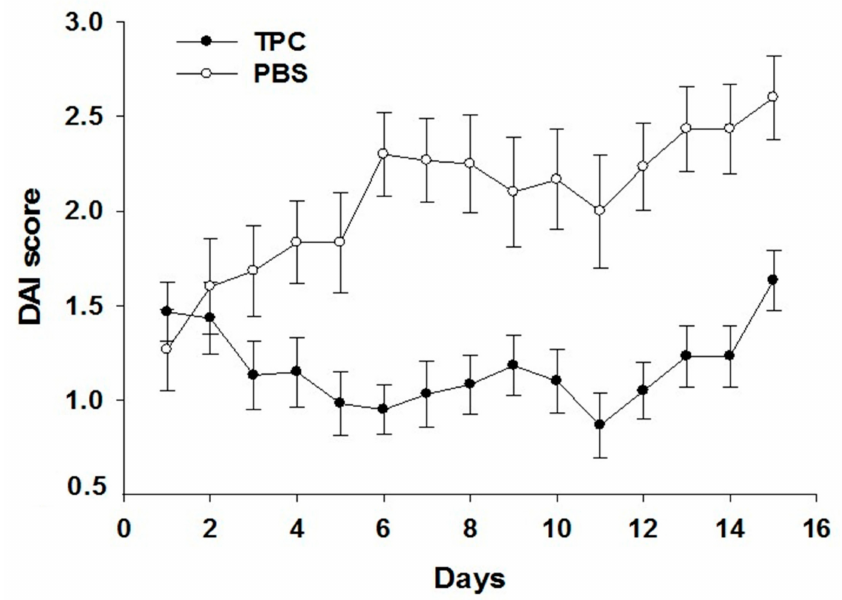
Figure 2. The e ff ect of TPC on disease activity in a chronic colitis model. Day 0 in this graph presents day 30 of chronic colitis. DAI score: The levels of DAI score are presented as an average number, in each group of mice ± standard error (n = 20 per group), treated with tuftsin–phosphorylcholine (TPC) or phosphate-bu ff ered saline (PBS). DSS mice that were treated with TPC had significantly lower average DAI score in comparison to mice treated with PBS ( p =